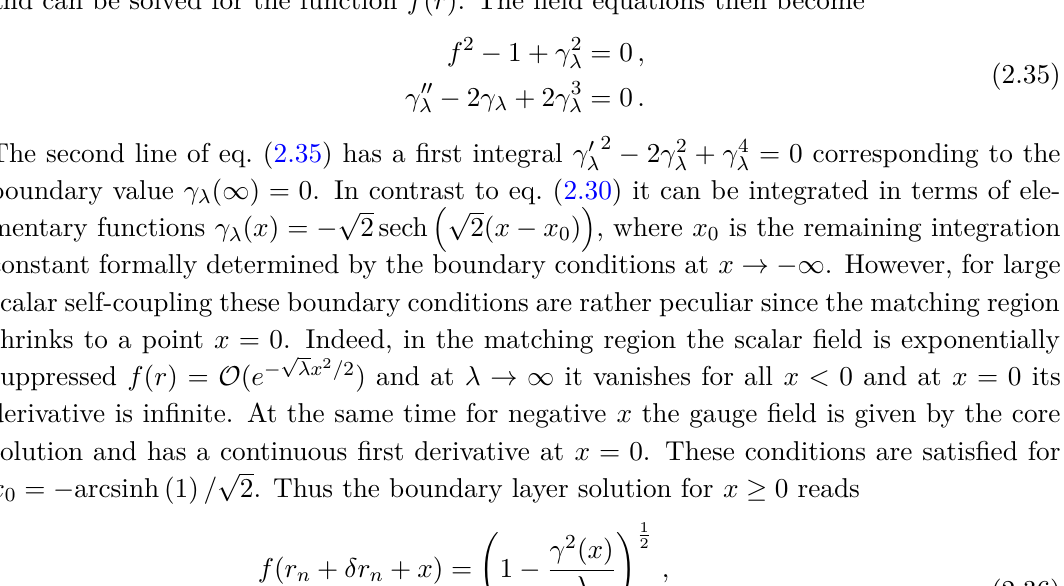
Figure 7 . Same as figure 6 but for the normalized gauge field γ ( x ) /